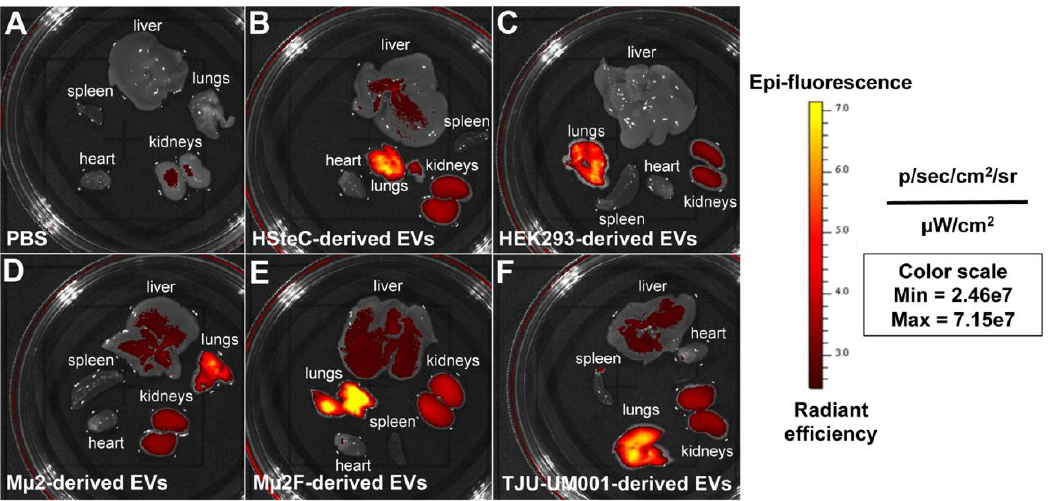
Figure 4. Accumulation of melanomic EVs in the liver and lungs of immunodeficient mice. ( A ) Inoculation of PBS served as control without EVs. ( B ) Large EVs derived from HSteCs, ( C ) HEK293, or ( D – F ) UM cell lines (M µ 2, M µ 2F, TJU-UM001) were labeled with Exoglow before being inoculated in the retro-orbital sinus of NCG mice ( n = 4/condition). Fluorescence of the liver, lungs, kidneys, heart, and spleen was analyzed with the IVIS after 24 h.